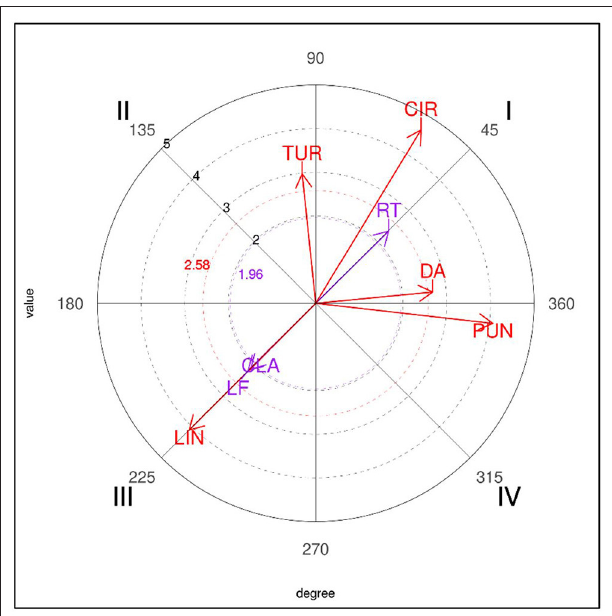
FIGURE 5 | Representation of the behavioral map for the 5P focal behavior in